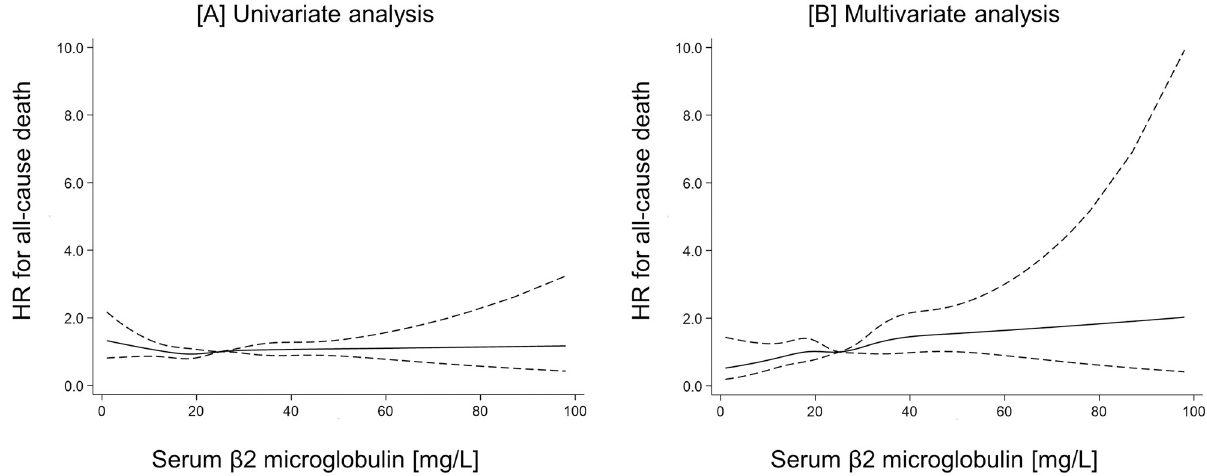
Fig 3. HRs for all-cause mortality derived from univariate [A] and multivariate analysis [B]. Lines represent HRs and 95% CIs based on restricted cubic splines for serum B2M levels with five knots at the 5th, 27.5th, 50th, 72.5th, and 95th percentiles. Abbreviations: HR, hazard ratio.